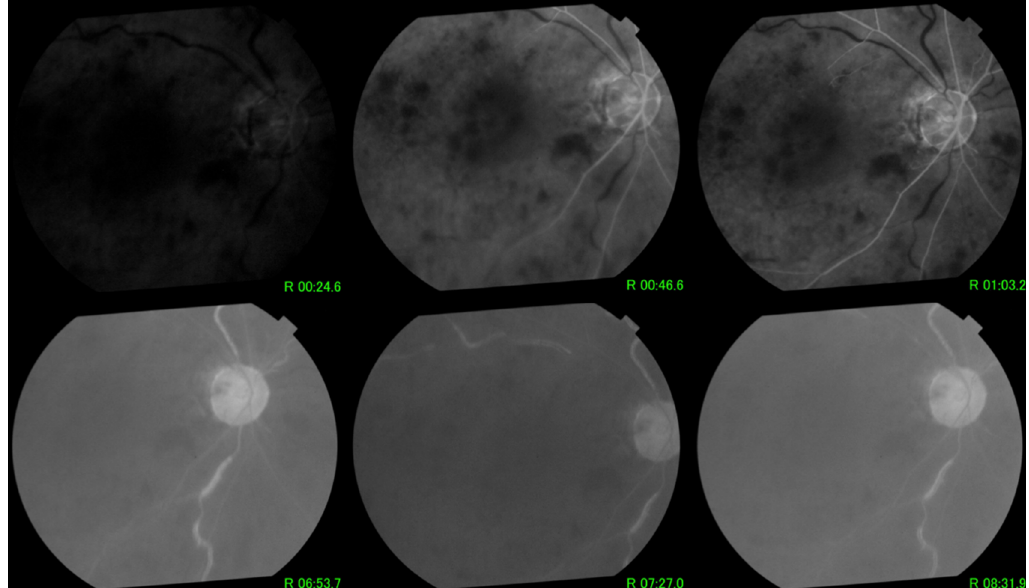
Figure 5: Fluorescein angiogram showing delayed filling of arteries, increased arteriovenous transit time with subsequent delay in venous filling, widespread capillary nonperfusion, and minimal macular edema There was also minimal cystoid macular edema at the fovea (Figure